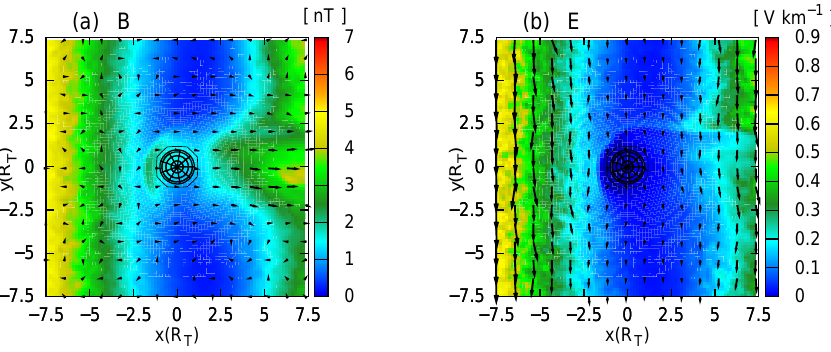
Fig. 9. Run #4 : Titan’s plasma environment under the influence of a periodic distortion according to eq. (12). The period T = 2 π/ω of the distortion is T = 3500 δt . The figure shows a snapshot of E and B in the satellite’s equatorial plane.